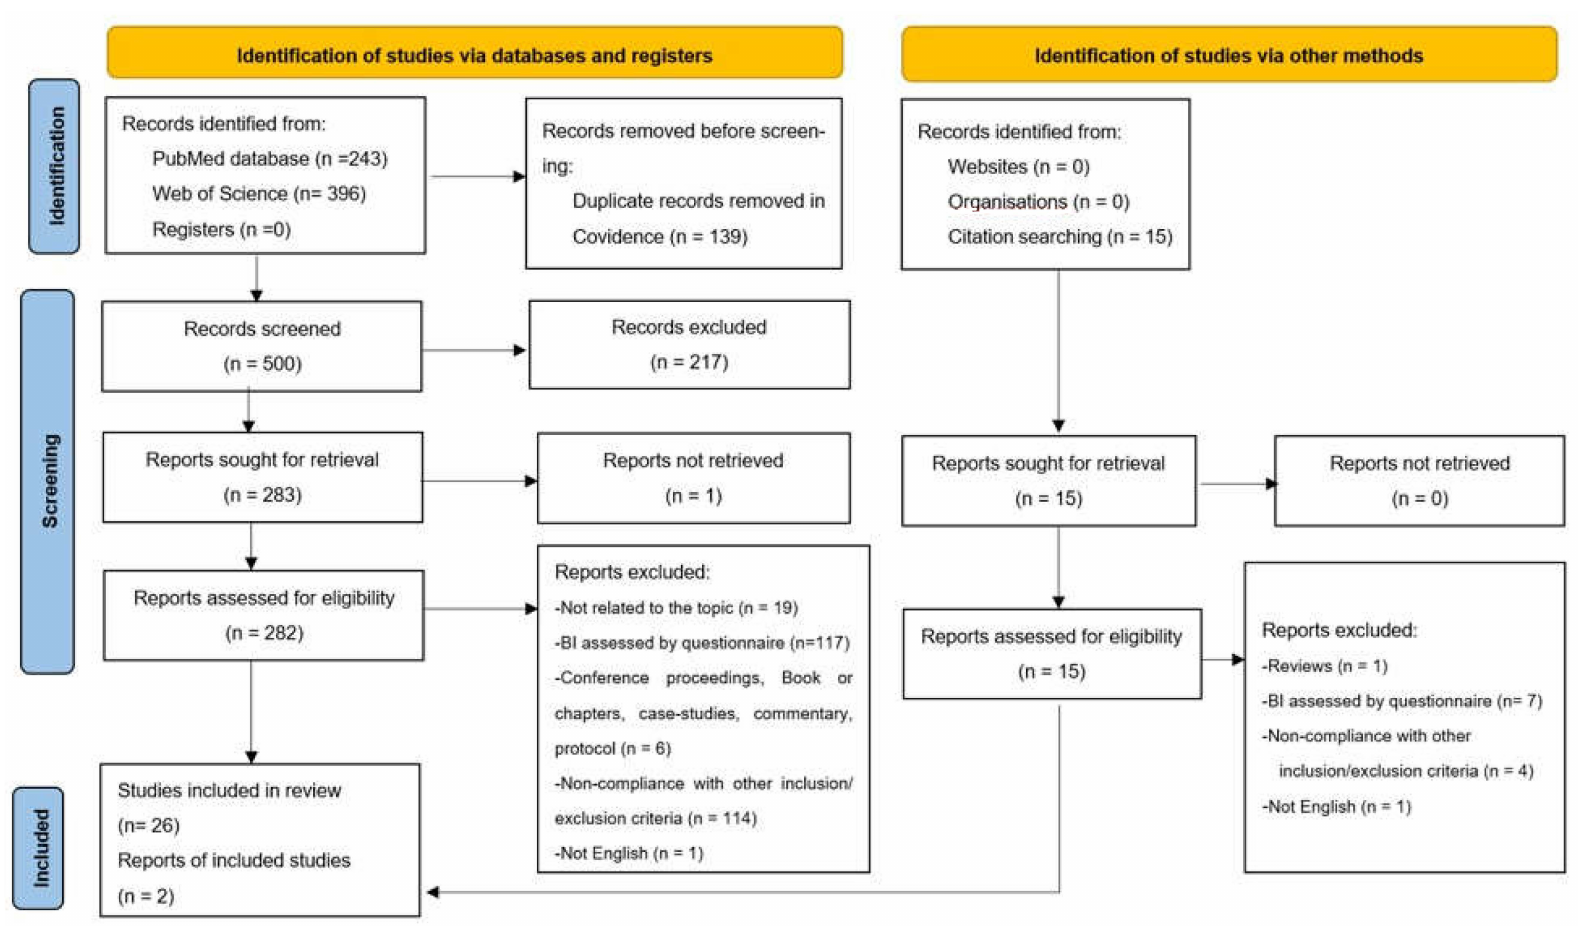
Figure 1. Flow chart of the study selection process (PRISMA 2020 flow